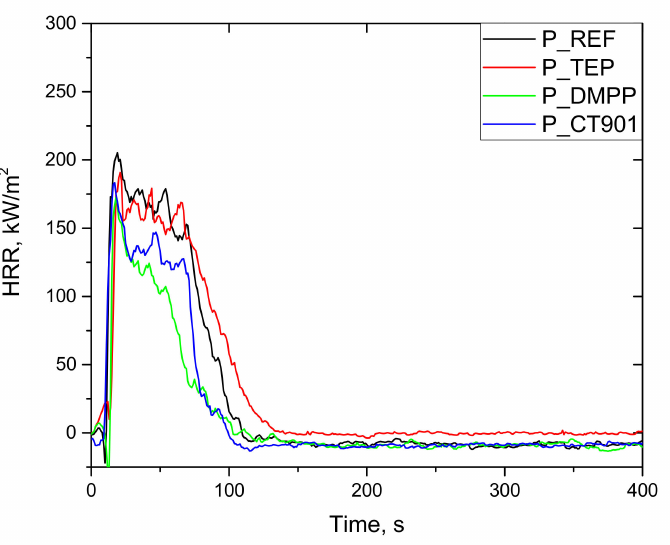
Figure 11. HRR curves (CONE) of rigid polyurethane foams without the addition of bio-polyol.